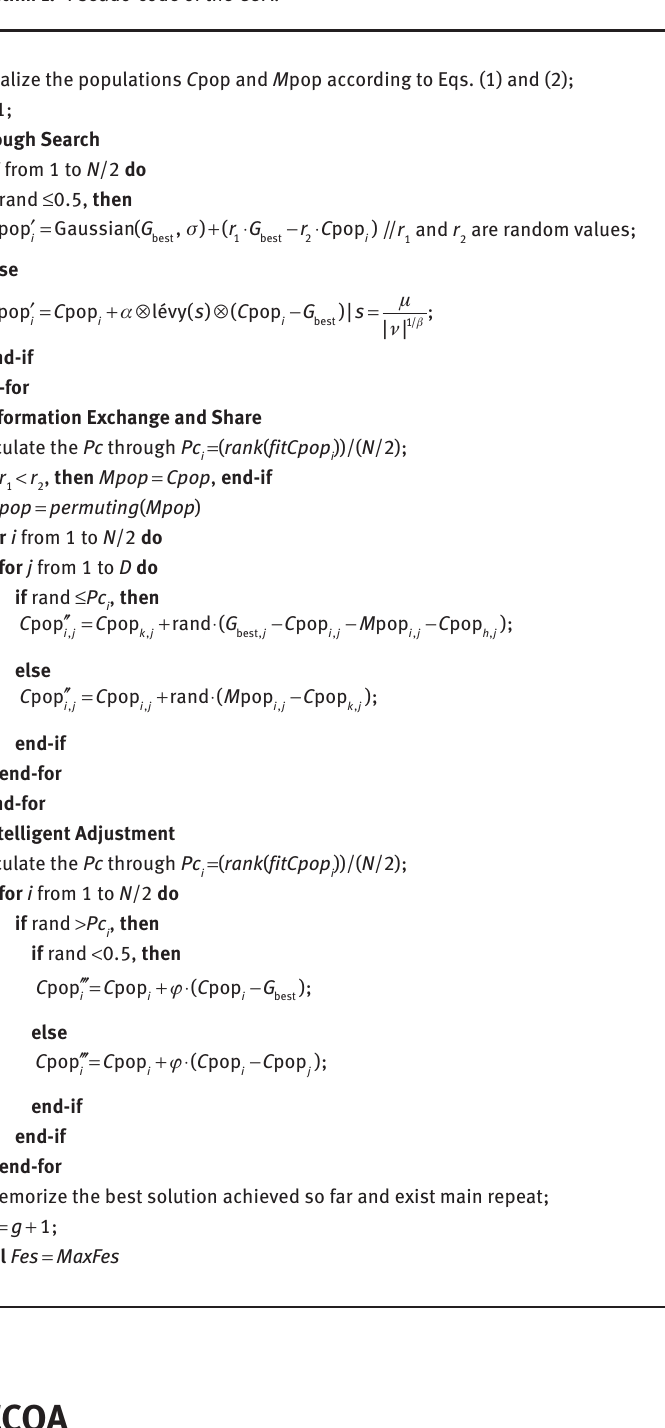
Algorithm 1: Pseudo-code of the